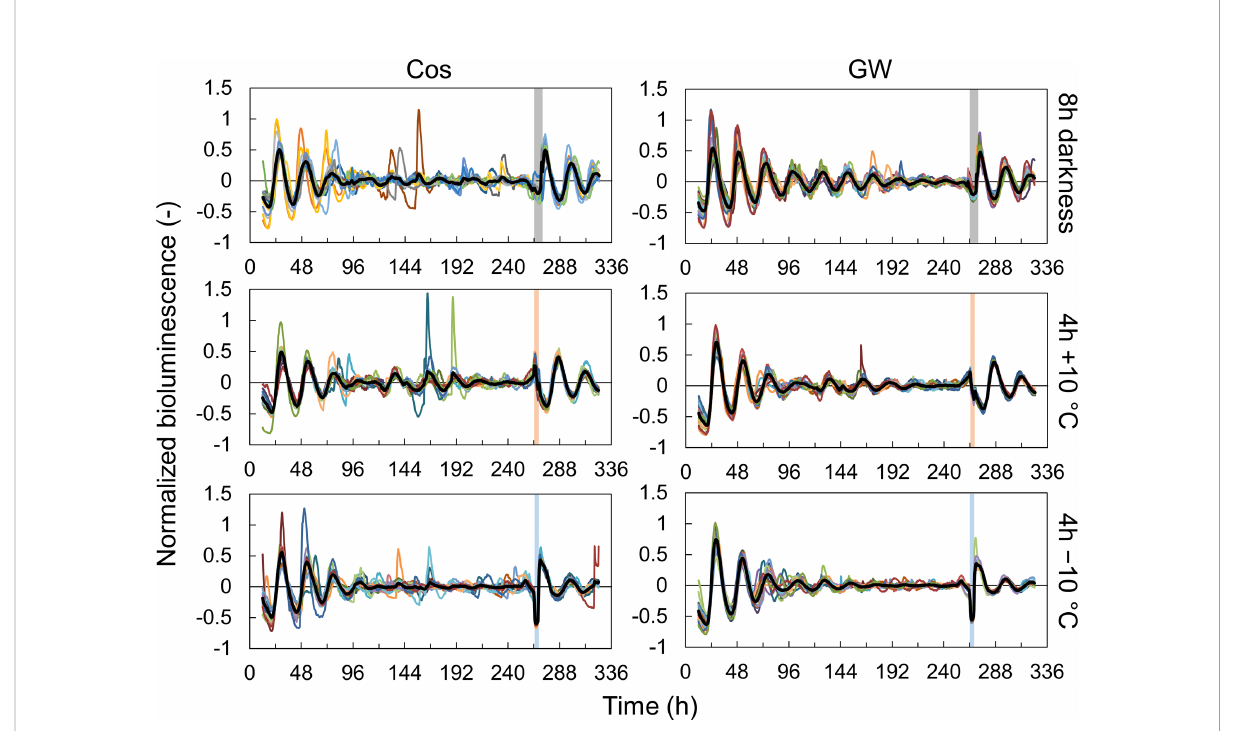
FIGURE 1 Singularity responses to 8-h darkness, 4-h +10°C, and 4-h − 10°C stimuli in Lactuca sativa L. (cv. Cos and Green Wave) during an experiment to investigate the effect of time lags in light: dark and temperature cycles during cultivation. Colored lines represent individual bioluminescence, and black lines represent mean normalized bioluminescence ( n = 13 in 8-h darkness, 15 in 4-h +10°C, and 16 in 4-h − 10°C in Cos, and n = 20 in all conditions in GreenWave). Vertical bars represent the